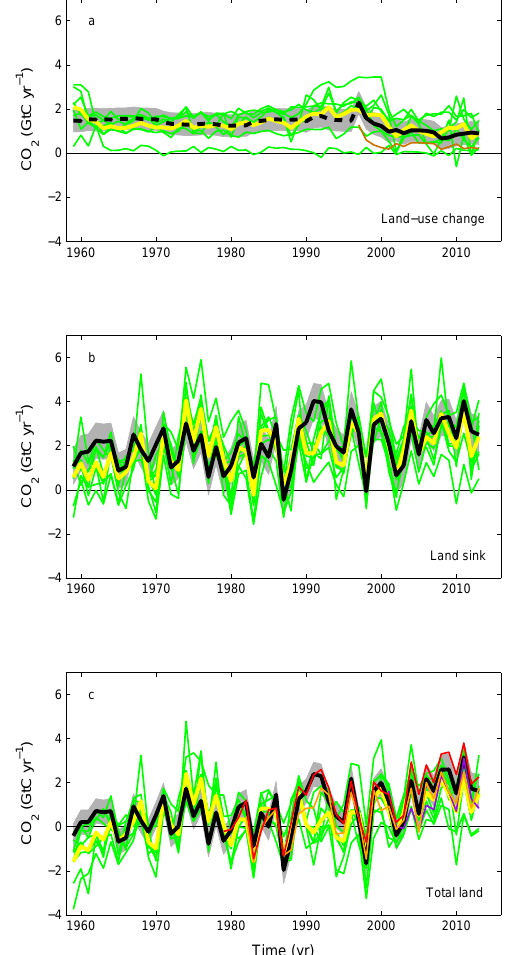
Figure 6. Comparison of the atmosphere–land CO 2 flux showing budget values of E LUC (black line). (a) CO 2 emissions from land- use change showing individual DGVM model results (green) and the multi-model mean (yellow line), and fire-based results (brown); LUC data prior to 1997 (dashed black line) highlights the start of satellite data from that year. (b) Land CO 2 sink ( S LAND ) show- ing individual DGVM model results (green) and multi-model mean (yellow line). (c) Total land CO 2 fluxes (sum of a + b ) from DGVM model results (green) and the multi-model mean (yellow line), at- mospheric inversions (MACC, v13.1 (Chevallier et al., 2005) in red; Rödenbeck et al. (2003) in orange; Peters et al. (2010) in purple; see Table 6), and the carbon balance from Eq. (1) (black). In (c) the inversions were corrected for the pre-industrial land sink of CO 2 from river input by adding a sink of 0.45GtCyr − 1 (Jacobson et al., 2007). This correction does not take into account the anthropogenic contribution to river fluxes (see Sect.